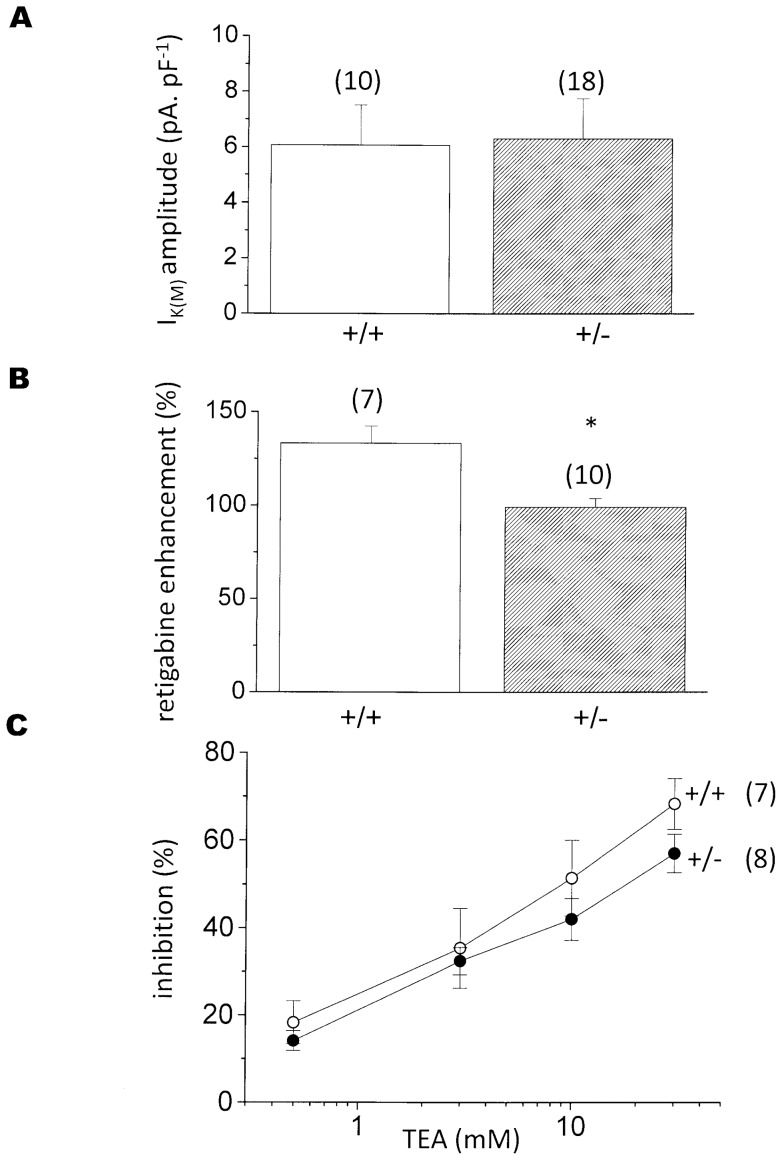
M-currents in sympathetic neurons from adult KCNQ2+/− mice.
A: mean M-current density (pA.pF−1) in wild-type (+/+) and KCNQ2+/− neurons. B: current enhancement by 10 µM retigabine, measured as % increase in standing outward current at −20 mV (see Fig. 3). C: mean % inhibition of wild-type (+/+) and KCNQ2+/− M-current by increasing concentrations of tetraethylammonium (TEA, mM). Vertical bars: SEM; numbers of neurons tested in brackets. * – indicates significant difference from wild type (P<0.005).